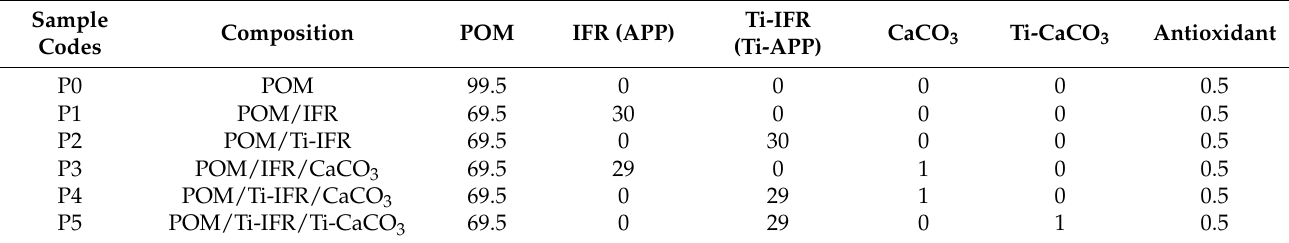
Table 1. Formulation and nomenclature of flame-retardant composites.